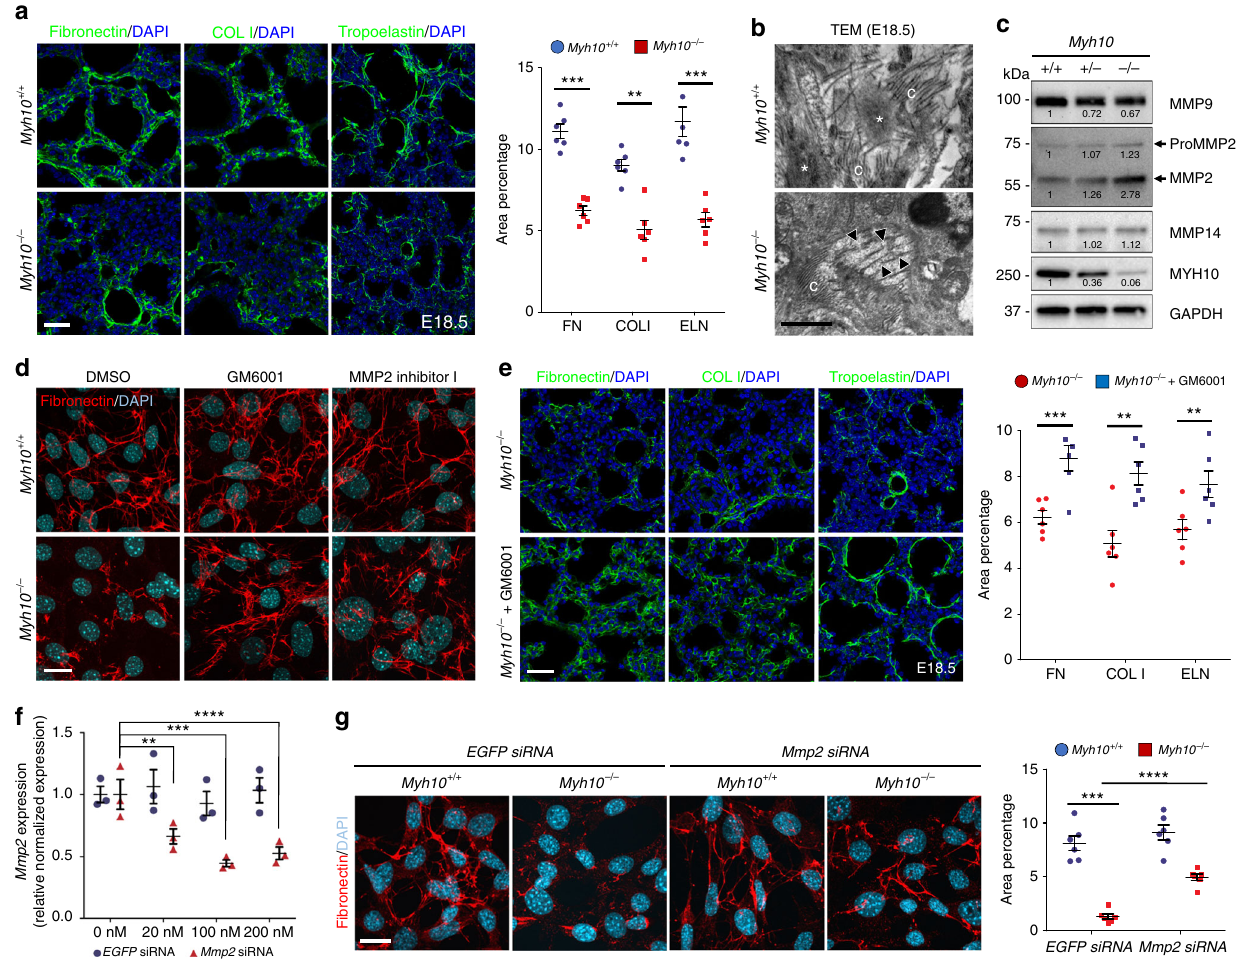
Fig. 3 Myh10 de fi ciency leads to disrupted ECM remodeling. a Immunostaining and quanti fi cation for Fibronectin, type I collagen (COL I), and Tropoelastin on Myh10 + / + ( n = 10) and Myh10 -/- ( n = 10) E18.5 lung sections. b Representative TEM images comparing elastic fi bers in Myh10 + / + ( n = 3) and Myh10 -/- ( n = 3) E18.5 lungs. Asterisks and arrowheads point to bundles and fragmented bundles of elastic fi bers, respectively; c collagenous fi brils. c Representative western blot (from three individual sets of lung lysates) of Myh10 + / + , Myh10 + /- , and Myh10 -/- lung lysates at E18.5. Values represent the densitometric ratio of Myh10 + /- and Myh10 -/- to Myh10 + / + after normalization to GAPDH. d Immunostaining (from fi ve individual sets of cultured cells) for Fibronectin in DMSO, GM6001, or MMP2 inhibitor I-treated Myh10 + / + and Myh10 -/- embryonic fi broblasts. e Immunostaining and quanti fi cation for Fibronectin, COL I, and Tropoelastin on Myh10 -/- ( n = 5) and GM6001-injected Myh10 -/- ( n = 5) E18.5 lung sections. f Expression level of Mmp2 in EGFP siRNA and Mmp2 siRNA-treated Myh10 + / + embryonic fi broblasts (from three replicates and individual sets of cultured cells) by RT-qPCR. g Immunostaining and quanti fi cation for Fibronectin in EGFP siRNA and Mmp2 siRNA-treated Myh10 + / + and Myh10 -/- embryonic fi broblasts. Error bars are means ± s.e.m. ** P < 0.01, *** P < 0.001, **** P < 0.0001, two-tailed Student ’ s t -test. Scale bars: 30 μ m ( a , e ), 20 μ m ( d , g ), 500 nm ( b